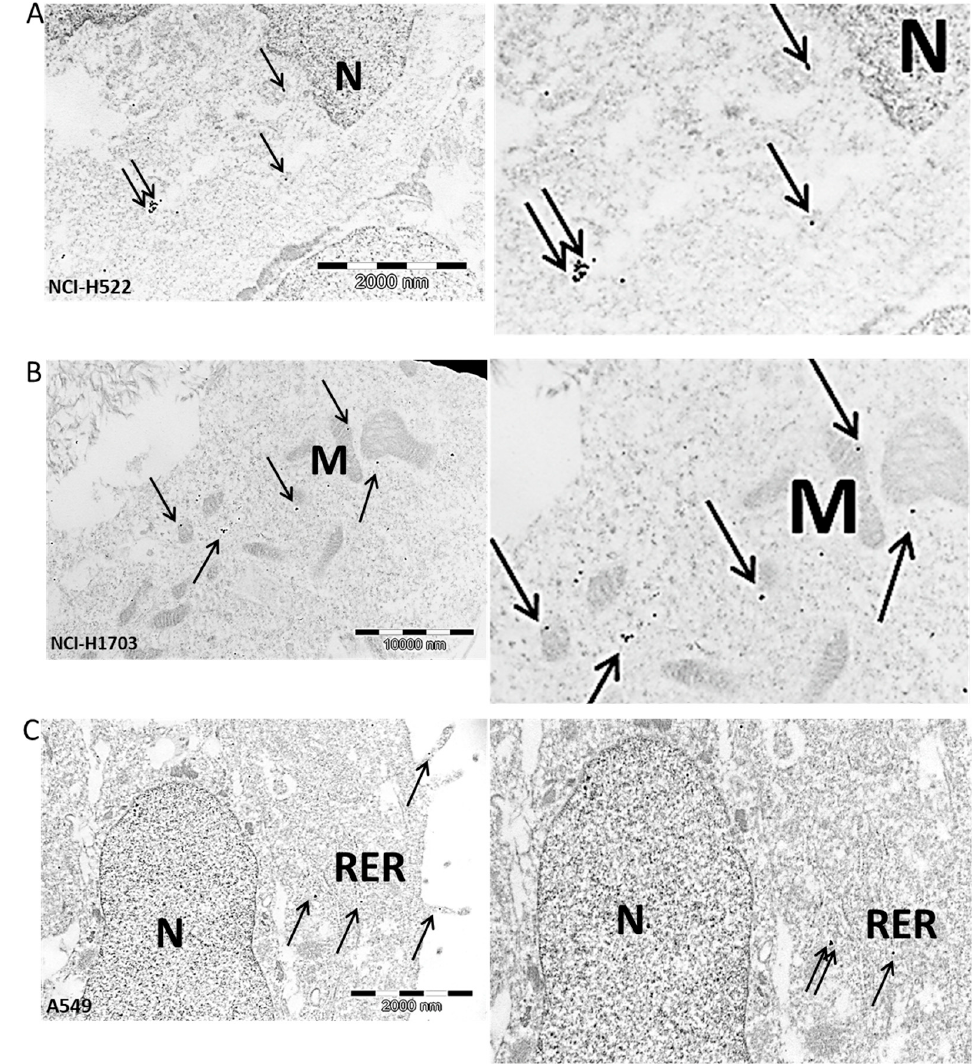
Figure 12. Positive immunogold reaction (black dots—indicated by arrows) point to irisin/FNDC5 expression in the cell cytoplasm in NCI-H522 cells—magnification on the right ( A ), in NCI-H1703 cell mitochondria-M membrane—magnification on the right ( B ), in rough endoplasmic reticulum-RER and in cytoplasmic extensions of A549 cell ( C ), N -nucleus, magnification ×25,000.